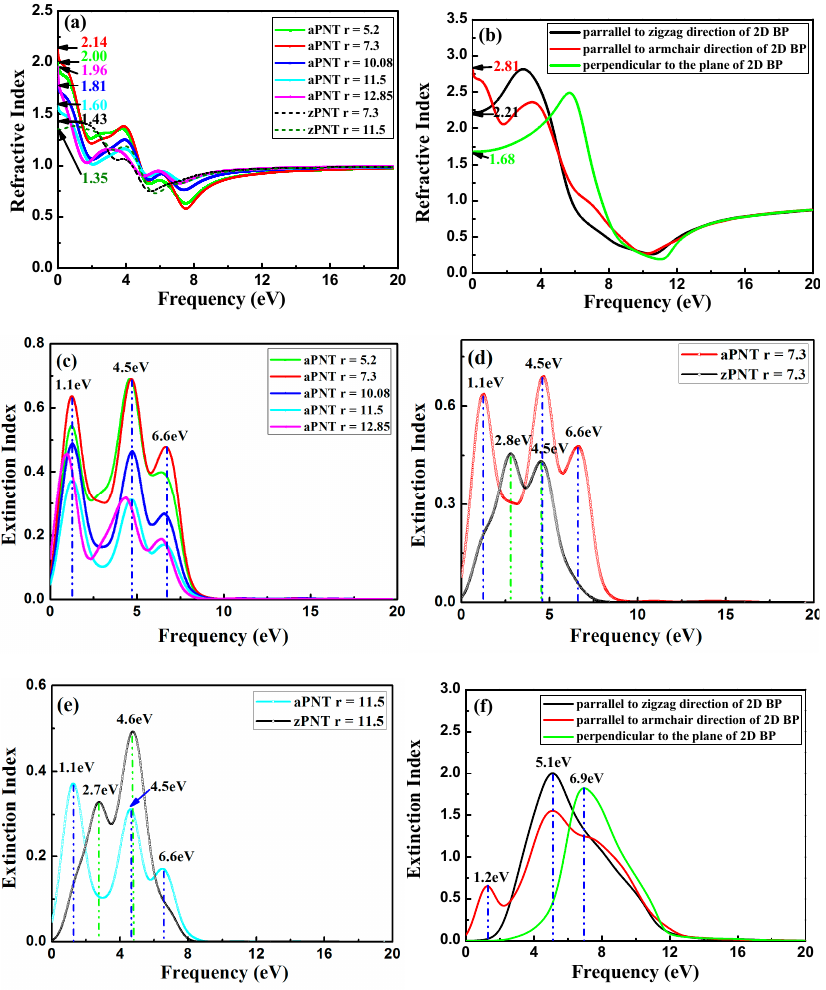
Figure 13. Refractive index of nanotubes with different radii and 2D BP: ( a ) refractive index n of aPNTs with different radii; ( b ) refractive index n of 2D BP along different polarizations; ( c ) extinctive index k of aPNTs with different radii; ( d ) extinctive index k of aPNT and zPNT with the same radius of 7.3 Å; ( e ) extinctive index k of aPNT and zPNT with the same radius of 11.5 Å, and ( f ) extinctive index k of 2D BP along different polarizations.